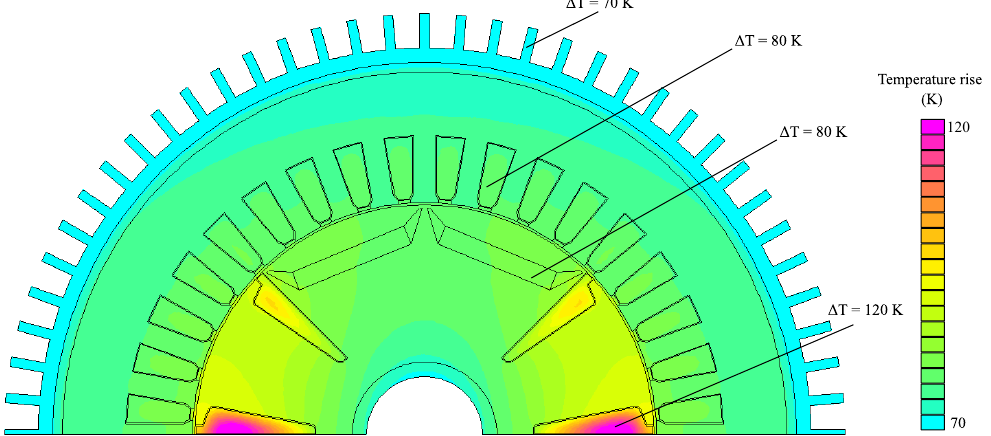
Figure 33. Temperature increase map for the HEPM motor with a forced-air cooling system and oil flux along the shaft.